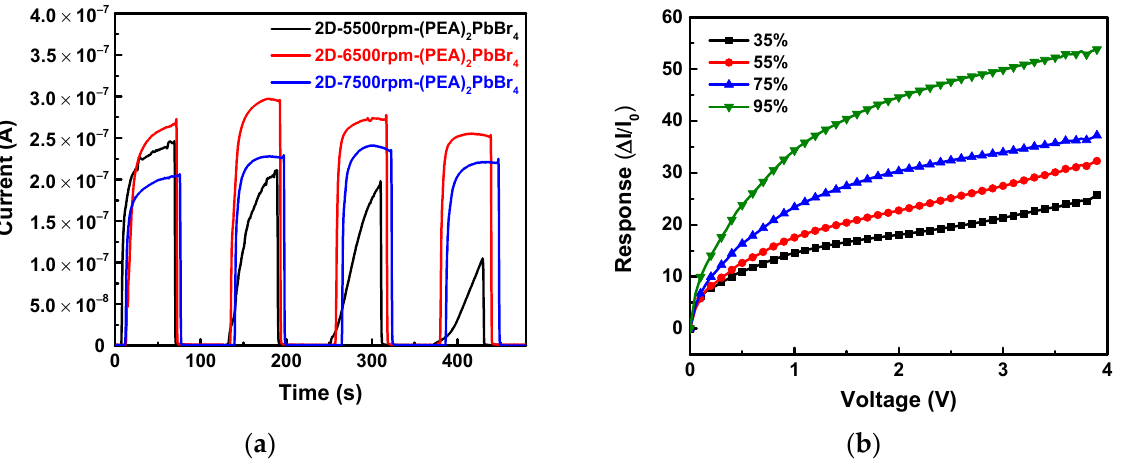
Figure 11. ( a ) Current–time (I–T) curves of 2D-(PEA) 2 PbBr 4 films formed with different spin speeds in ethanol vapors environment. ( b ) Sensor response of 2D-6500rpm-(PEA) 2 PbBr 4 vapor sensor after exposure to different concentrations of ethanol vapors.